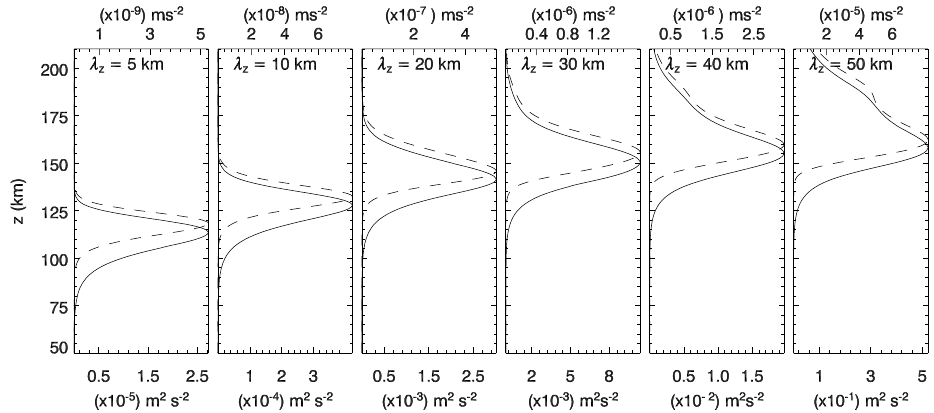
Fig. 6. Vertical profiles of MF( z) (solid line, lower axis) and the corresponding body force (dash line, upper axis) for the GWs with initial λ z = 5, 10, 20, 30, 40, and 50km, respectively (GWs A–F Table 1) propagating in the isothermal atmosphere with Pr = 1. The scaling factors increase from left to right.